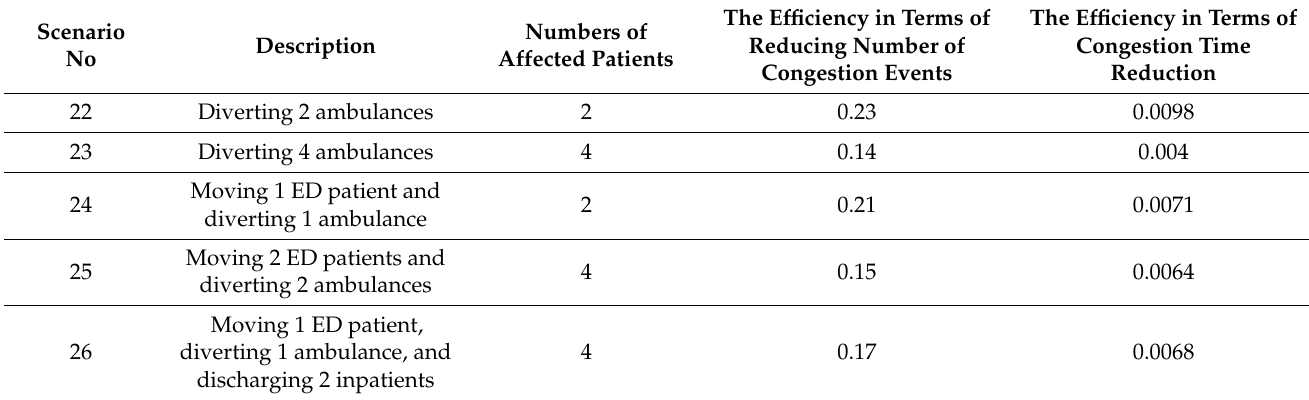
Table 2. Comparing the efficiency of a single strategy and combined